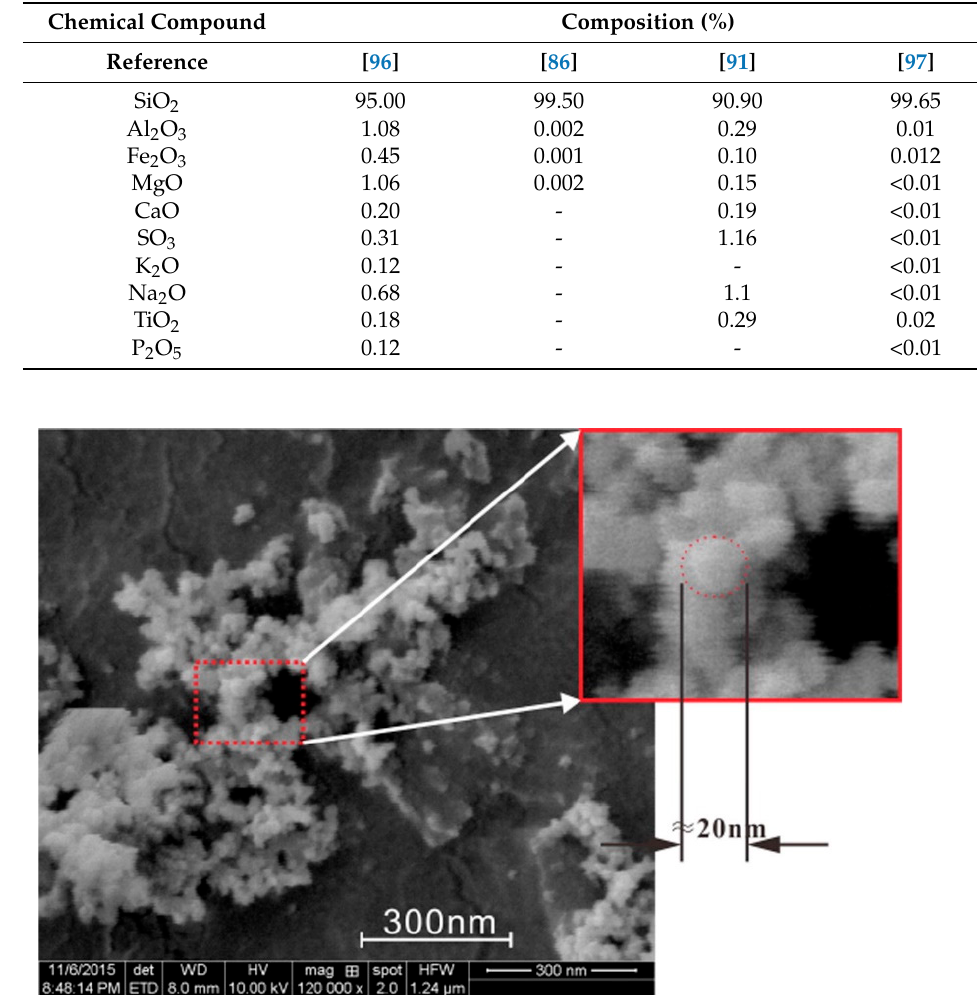
Table 3. Chemical composition of nano-silica.